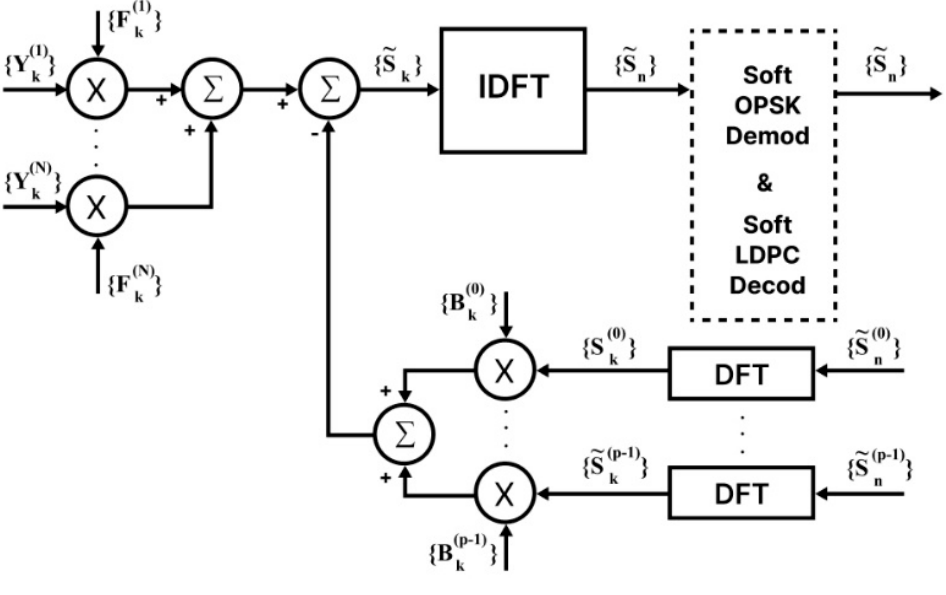
Figure 2. Block diagram using SC-FDE receiver.